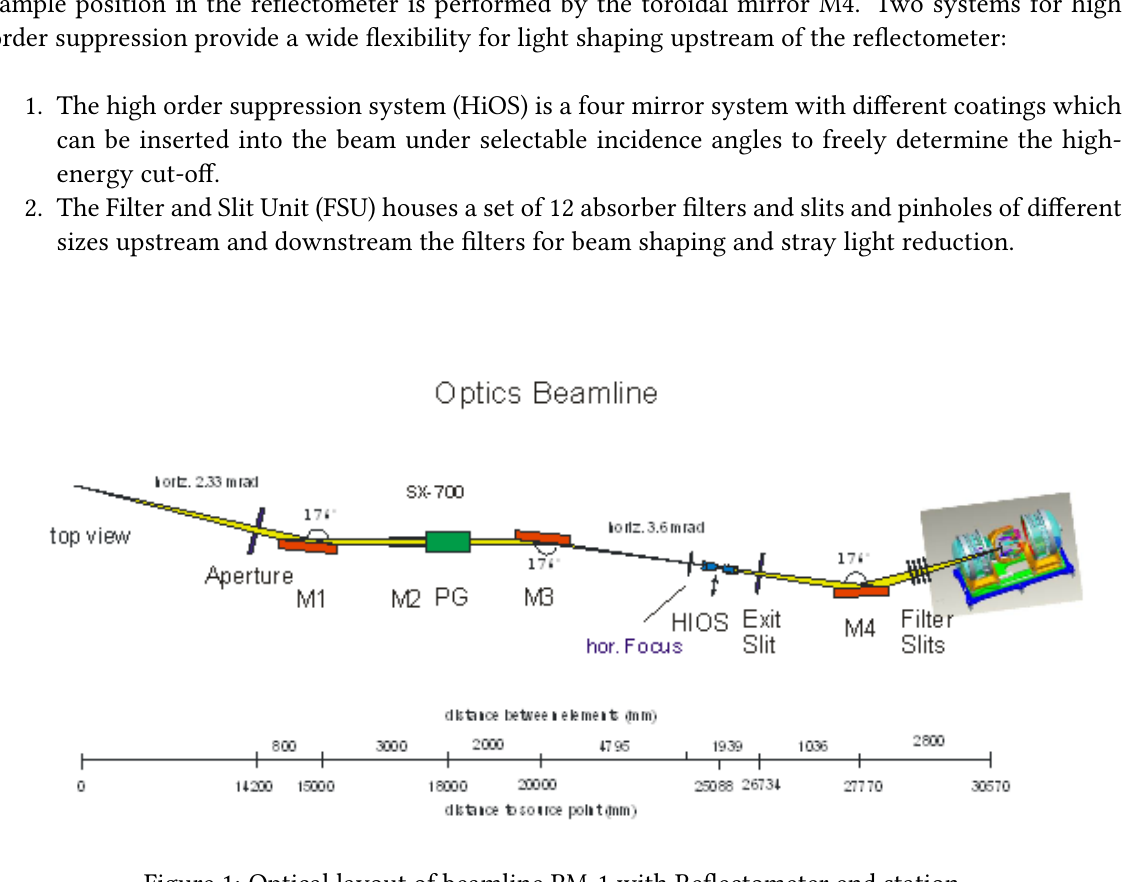
5 Beamline all-over Performance Data